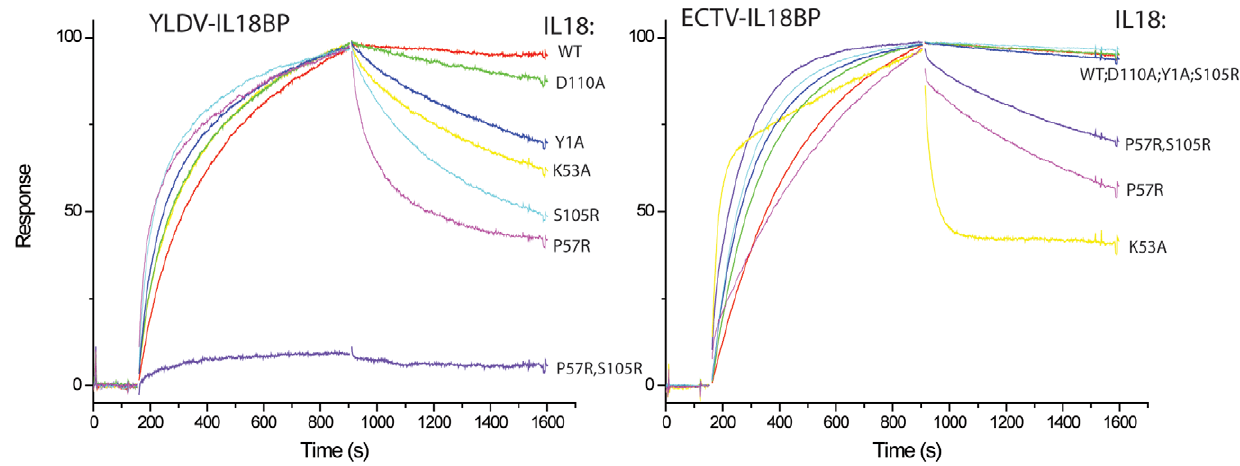
Figure 9. Biacore SPR analysis of IL18 mutants. Biotinylated YLDV-IL18BP and ECTV-IL18BP were captured on two different flow cells in a BIAcore streptavidin-coated CM5 chip, and their binding with IL18 was monitored simultaneously with a BIAcore 3000 sensor. The injection of IL18 started at , 150 s and stopped at 900 s. The colored lines are the responses obtained with different IL18 mutants and normalized to a maximum of 100 RU (except for P57R, S105R for YLDV-IL18BP) for ease of comparison. YLDV-IL18BP and ECTV-IL18BP were expressed and secreted from mammalian cells and underwent in vitro biotinylation as described in Materials and Methods.